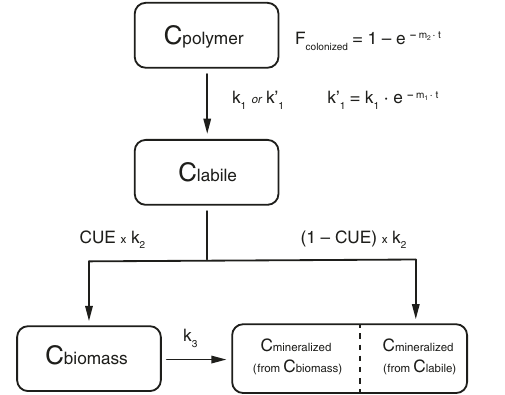
Fig. 8 | Carbon fl uxmodelusedtodescribepoly(butylene succinate) (PBS)and cellulose biodegradation dynamics during soil incubation. Boxes represent carbon pools (C i ) where C polymer refers to carbon in bulk PBS and cellulose, C labile is PBS- and cellulose-derived carbon in low molecular weight breakdown products, C mineralized is PBS- and cellulose-derived carbon in CO 2 (formed either directly catabolically or from the mineralization of microbial biomass that had fi rst incorporated PBS- or cellulose-derived carbon), and C biomass is carbon in the microbial biomass, microbial necromass and the soil organic matter pool. Arrows represent fl uxes of carbon between pools and are labelled with the respective kinetic rate constants ( k i ); k 1 and k 1 ’ are the rate constants of depo- lymerization to form lower molecular weight compounds (C labile ), k 2 is the rate of microbial substrate utilization, and k 3 refers to the mineralization rate of soil microbial biomass. F colonized represents the fraction of the polymer surface which has been colonized by microbial degraders and which therefore is accessible for enzymatic breakdown. CUE is the carbon use ef fi ciency and representsthe fraction of totallabilecarbontakenup by microorganisms which is incorporated into microbial biomass. Rates of carbon transfer between pools are calculated based on differential equations, with kinetic parameters opti- mized by fi tting experimental data of C mineralized , and additionally of C polymer fi ts. The model is explained in more detail in the residual for some PBS model Supplementary Note